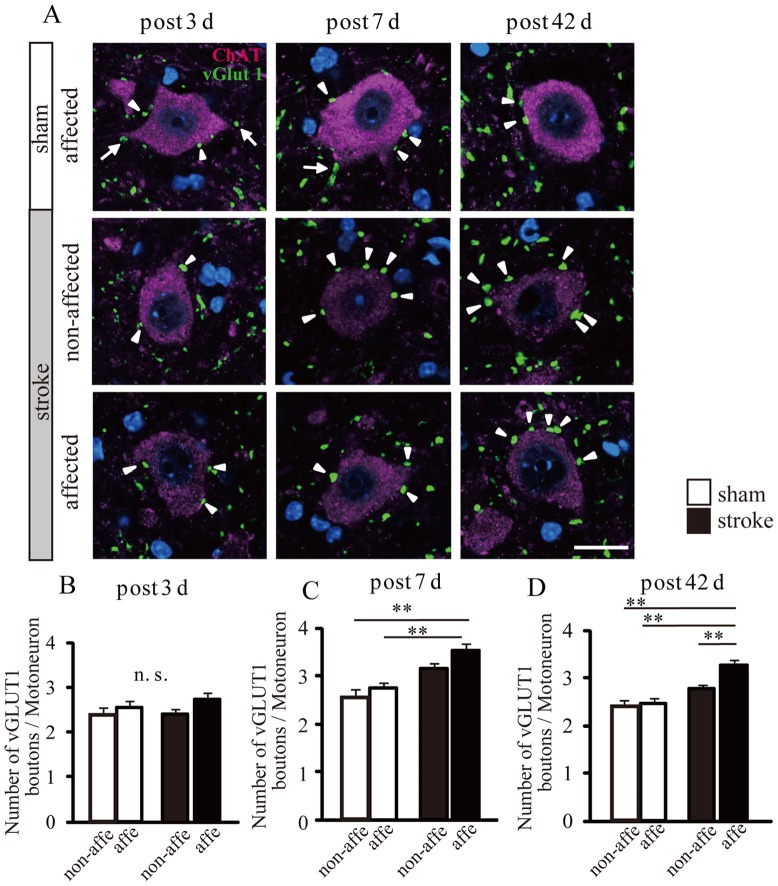
The number of vGluT1-positive boutons on motoneurons after stroke.A: Dual labeling of vGluT1 (green) and ChAT (magenta) at 3, 7, and 42 d after stroke. Arrowheads show vGuT1-positive boutons contacting motoneuron somata and the arrows show non-counted boutons because the boutons did not contact the somata. Scale bar = 20 “Insert>Symbols” µ m. B-D: Quantification of the number of vGluT1-positive boutons on plasma membranes of spinal motoneurons in sham and stroke mice at 3, 7, and 42 d after stroke. Error bars on graphs represent S.E.M. One-way ANOVA with post hoc Tukey-Kramer test, **p<0.01.